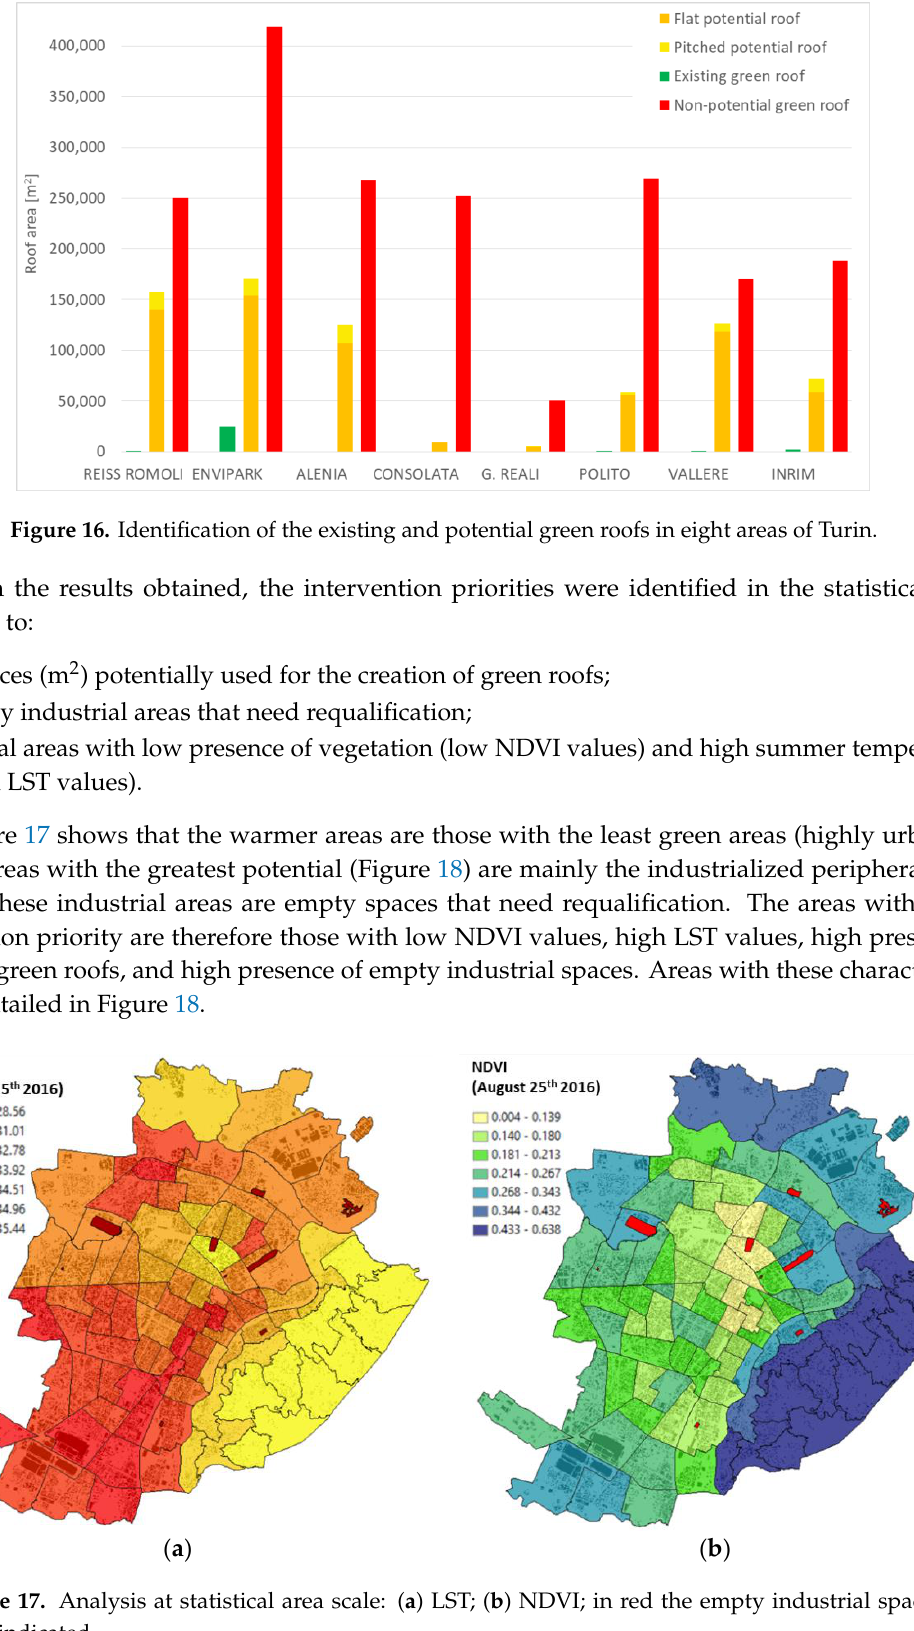
Figure 15. Identification of the existing and potential green roofs in the EnviPark area.